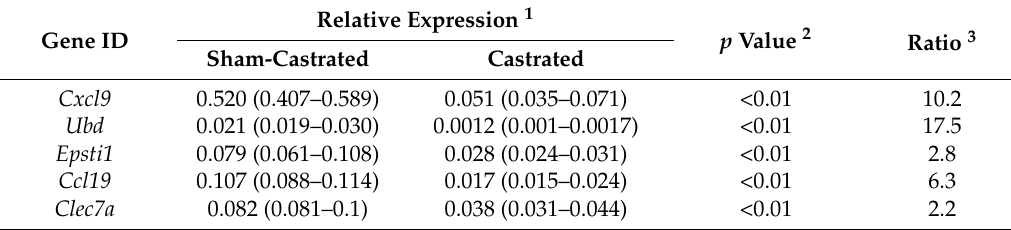
Table 3. Downregulation of disease-relevant genes in lacrimal glands of castrated male NOD mice.